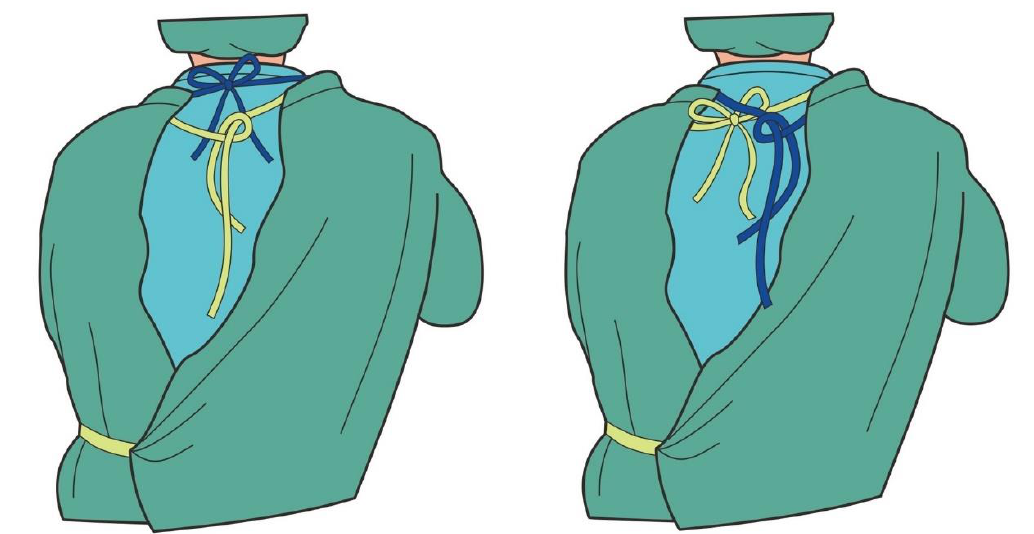
Figure 5. Schematic illustration of the common patterns of rear neck tie loosening.